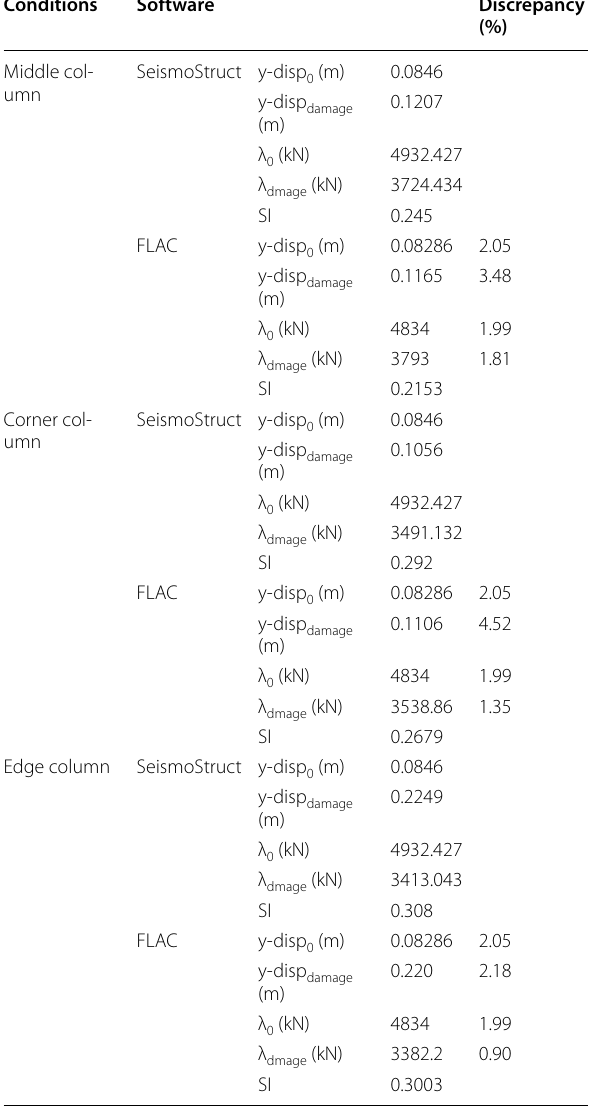
Table 5 Redistribution of the imposed loads and Y-displacement in the 20-story RC frames.